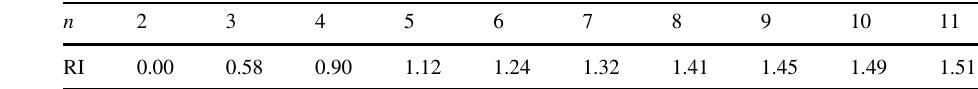
index values for comparisons according to matrix n